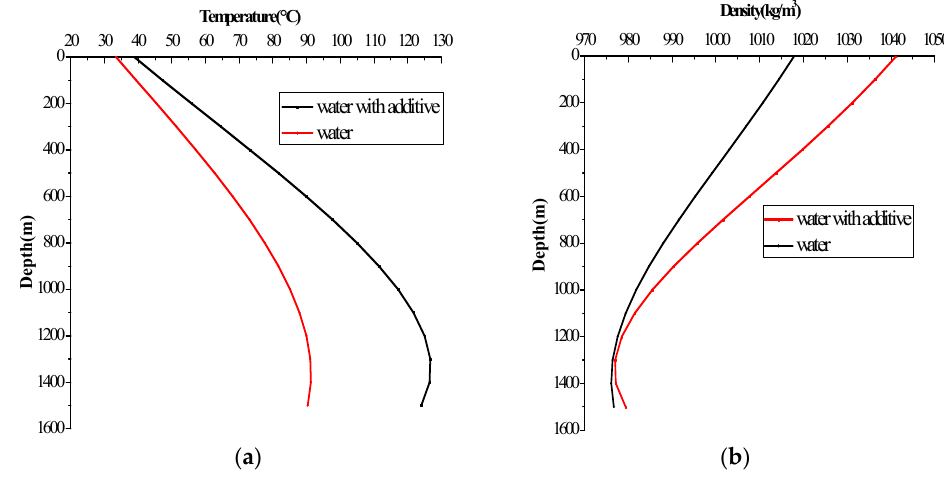
Figure 9. Temperature ( a ) and ECD ( b ) in the annulus with the rheological model of the pipe (circulating 8 h).